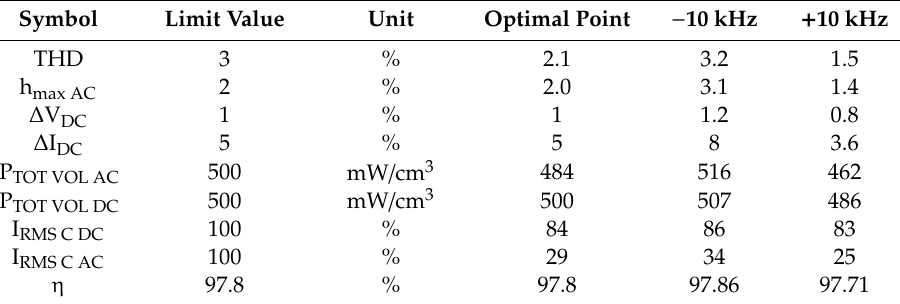
Table 3. Comparison of the constraints with lower and higher